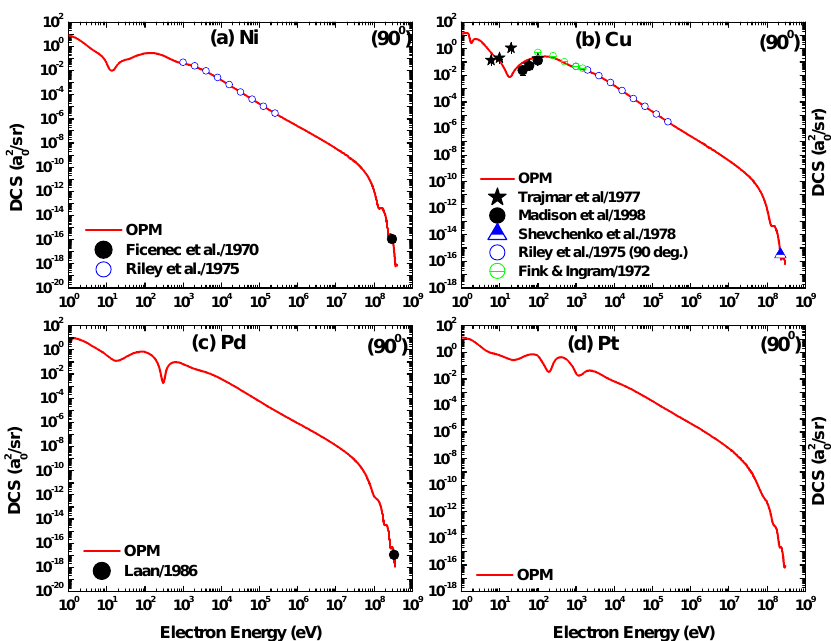
Figure 16. Energy dependence of the differential cross-sections for electron scattering from ( a ) Ni 58 , ( b ) Cu 63 , ( c ) Pd 108 , and ( d ) Pt 196 at a scattering angle of θ = 90 ◦ . Experiment: Madison el al. [36], Trajmar et al. [37], Ficenec et al. [41], van der Laan [44], and Shevchenko [43]. Theory: Present OPM (——), Riley et al. [40], and Fink and Ingram [39].